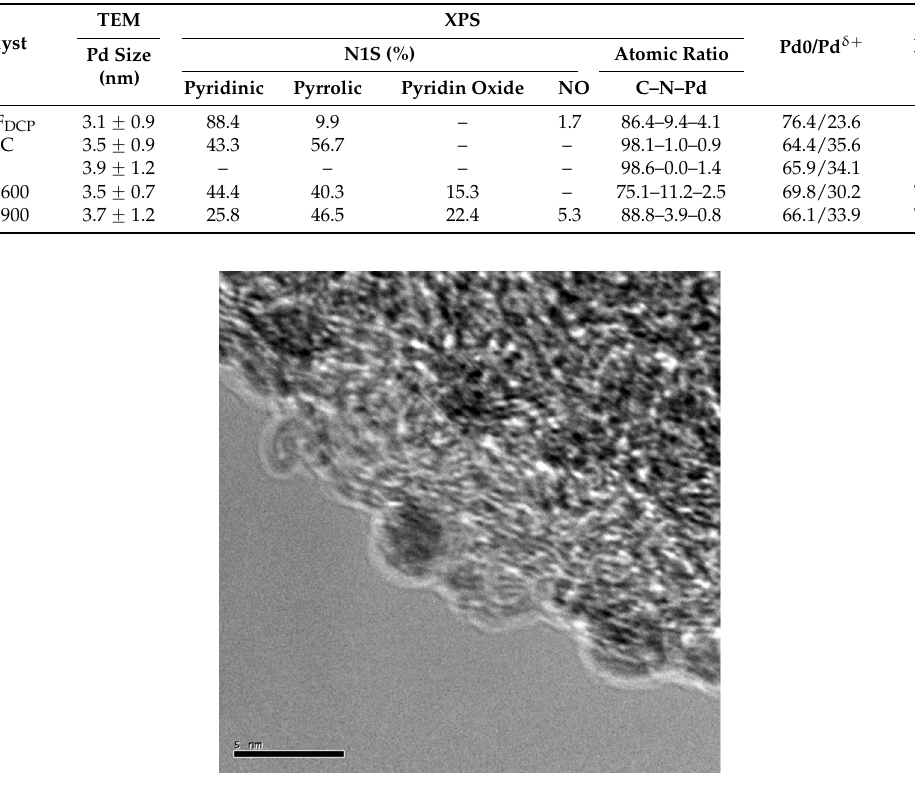
Figure 5. TEM representative image of Pd/GAG600.